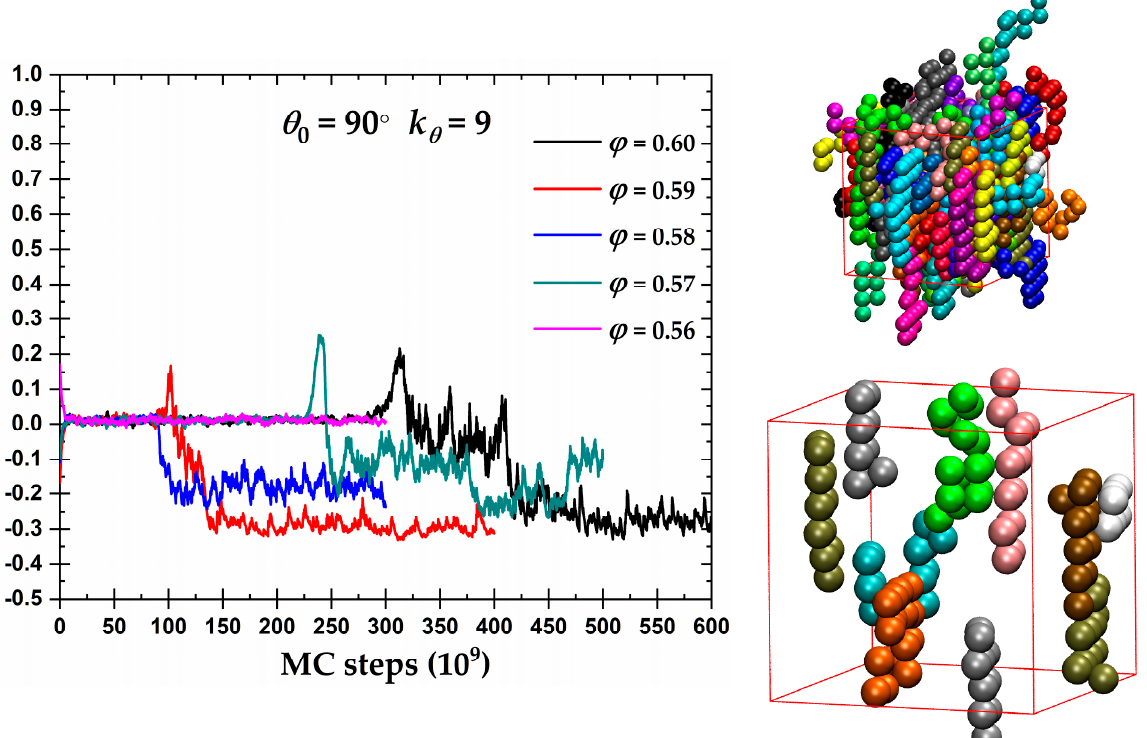
Figure 5. ( Left ) Exponential moving average of the orientational order parameter, q , as a function of MC steps for the 100-chains N av = 12 semi-flexible system with bending constant k θ = 9 and equilibrium bending angle θ 0 = 90 ◦ at different packing densities, ϕ . ( Right ) Visual representations at ϕ = 0.59 showing all 100 chains ( top ) and 10 randomly selected chains ( bottom ) with coordinates of the monomers being fully unwrapped in space. Monomers are colored according to the parent chain. Images created with VMD visualization software [141]. Individual panels are also available as stand-alone, interactive, 3-D images (in Supplementary Materials).